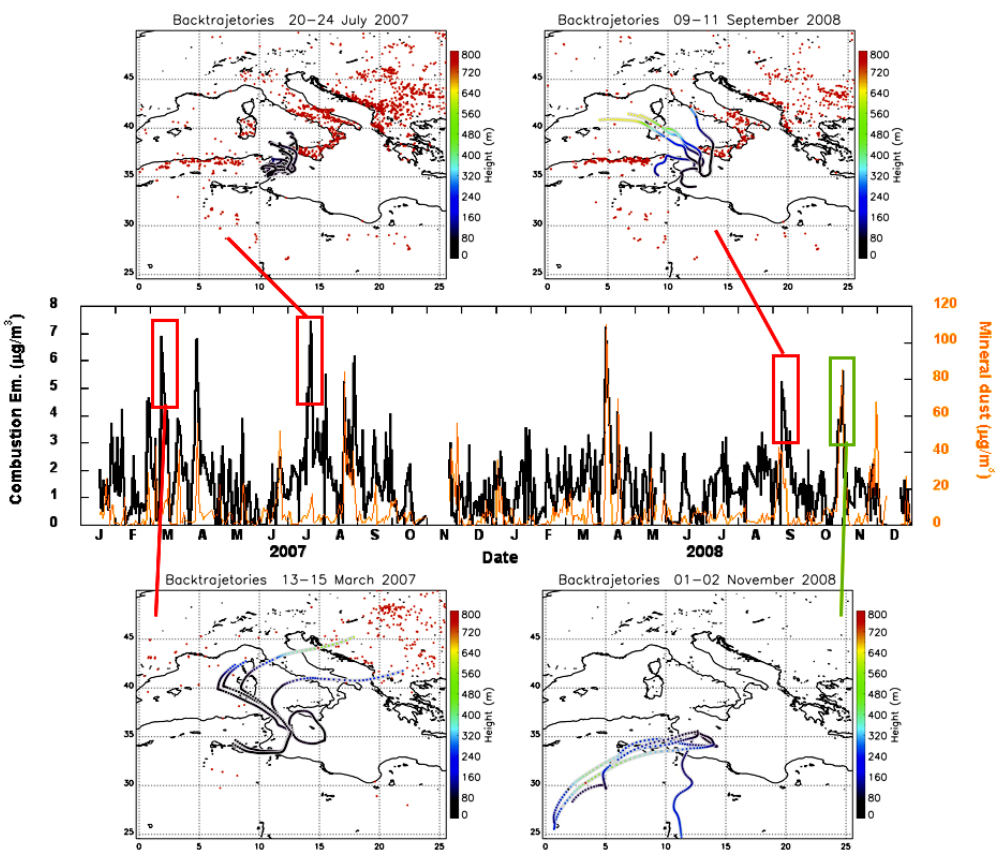
Figure 6. Temporal evolution of the “combustion emissions” and “mineral dust” sources; examples of trajectories from fires are evidenced in red, together with an example of advection from the Saharan region (green).